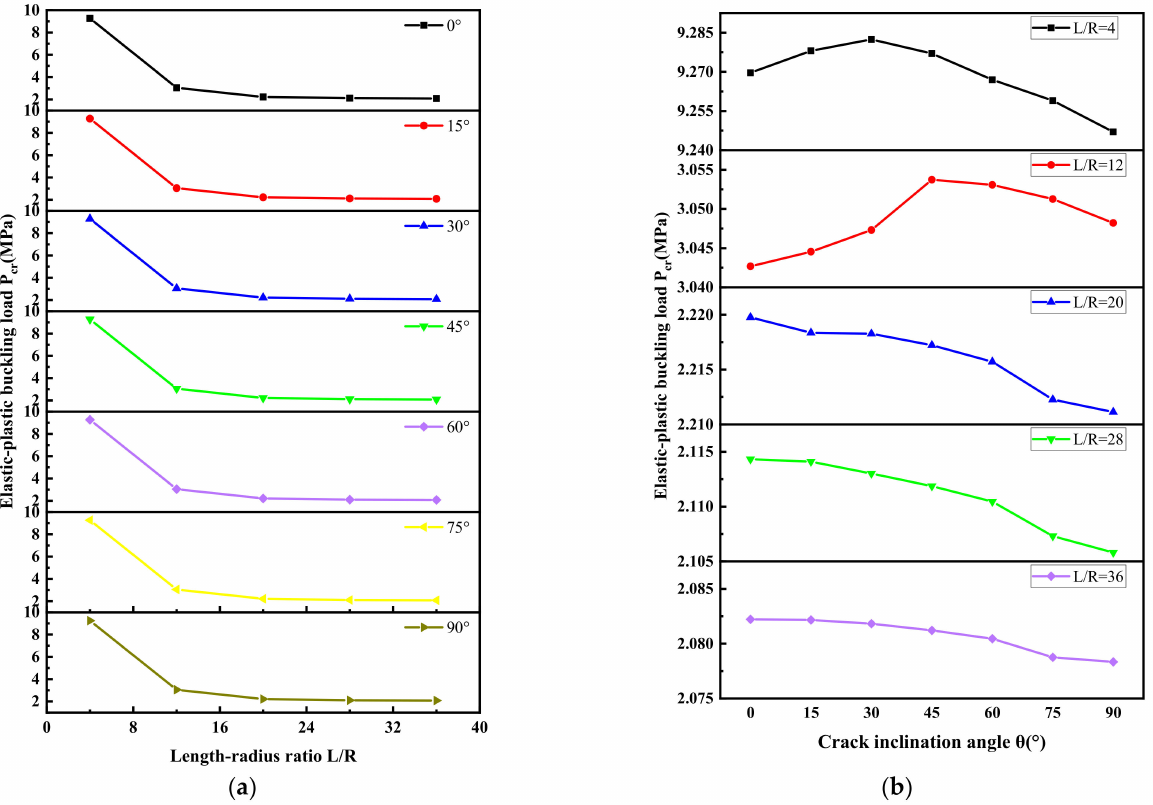
Figure 10. Relation between length-radius ratio and elastic-plastic buckling load ( a ) Different length- radius ratios; ( b ) Different crack inclination